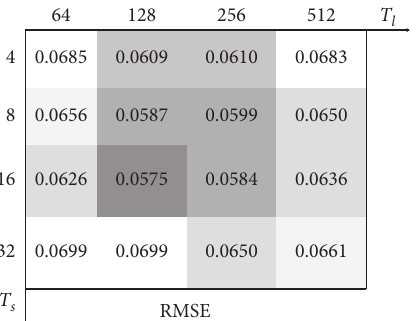
T s and long window size l . We use different